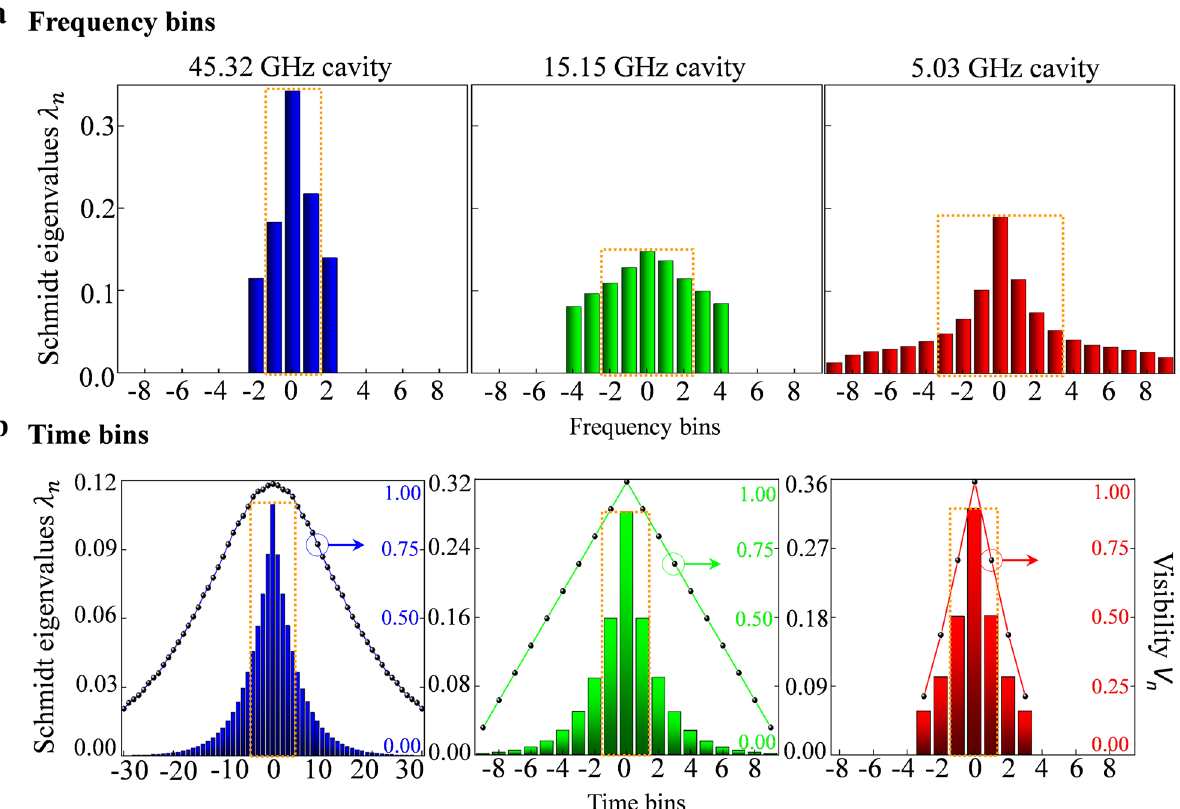
Fig. 5 Schmidt mode decompositions for three high-dimensional BFCs. a The Schmidt mode eigenvalues for measured frequency-binned states obtained using our 45.32, 15.15, and 5.03 GHz FSR cavities with ≈ 2 mW pump power (calculation detailed in Supplementary Discussion IV). The obtained frequency-bin Schmidt numbers are K Ω ,45 GHz ≈ 4.31, K Ω ,15 GHz ≈ 8.67, and K Ω ,5 GHz ≈ 11.67 for the three cavities. b The Schmidt mode eigenvalues versus different time bins from HOM interferometry and the corresponding visibilities of the HOM-interference recurrences. The blue, green, and red bars indicate the time-binned Schmidt eigenvalues for the 45.32, 15.15, and 5.03 GHz cavities, respectively, and the black points indicate the visibilities from HOM interferometry. The central HOM dip is labeled as 0 as a reference. The dominant Schmidt mode eigenvalues for each high-dimensional BFC have been highlighted within the orange-dashed boxes and detailed in Supplementary Discussion IV. The obtained time-bin Schmidt numbers are K T ,5 GHz ≈ 5.16, K T ,15 GH z ≈ 6.71, and K T ,45 GHz ≈ 18.30 for the three